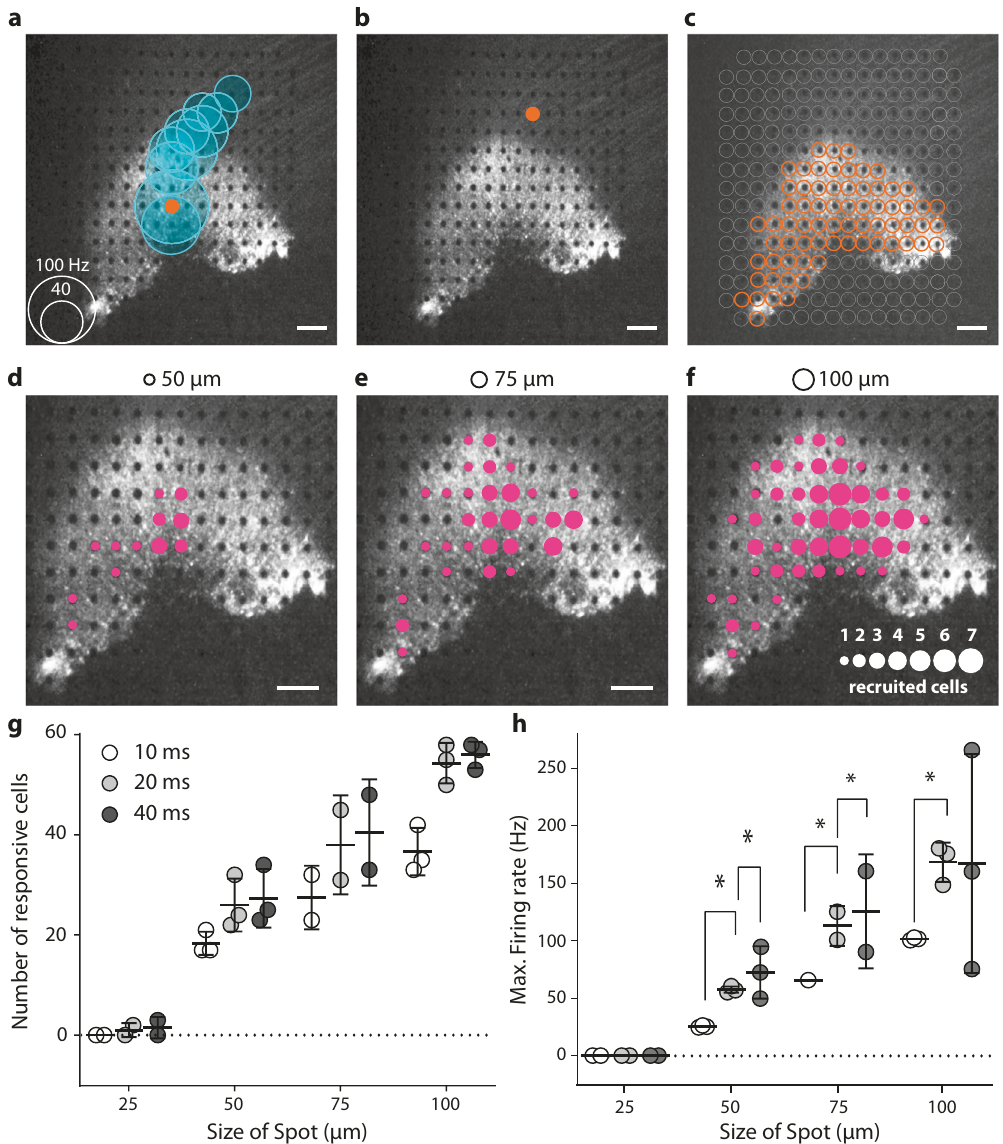
Fig. 5 Spatiotemporal resolution for discrete stimulation. a A focal light stimulation activated several different electrode channels on the transfected perifoveal area. The black and white image shows the fl uorescence present in the perifovea area, with electrodes visible as black dots The orange dot shows the site of light stimulation (with a diameter of 100 µ m and a duration of 40 ms spots. The blue circles are centered on the channels for which spikes were recorded suggesting a strong propagation activity. The size of the blue circles is proportional to the maximum spiking rate within a 100 ms window after stimulation, according to the scale in the bottom left corner. b When the light spot is directed toward another electrode at a location at which the RGC axons were stimulated, rather than the soma as in a; no response was measured (absence of blue circles). c Orange dots represented the sites at which stimulation resulted in a spiking response recorded on at least one MEA channel. These locations exactly match the pattern of intense fl uorescence in the perifoveal area. d – f Images showing the extent of responses for 20 ms presentations of spot stimuli of different sizes (displayed at the top of the images). The sizes of the magenta circles indicate the numbers of cells activated by a spot at that particular position (see the scale in the lower right part of the panel). For a – f , scale bars indicate 200 µ m. g , h Total number of recorded cells ( g ) and mean fi ring rate ( h ) over the entire electrode array is highly correlated with spot size and duration. For all stimulus durations (10 ms, 20 ms, and 40 ms), the increase in size from 25 to 50 µ m, 50 to 75 µ m, and 75 to 100 µ m led to a signi fi cant increase in the fi ring rate of the cells, not shown on the fi gure (all P < 0.005, n = 3, see “ Methods ” for details); for increases in duration for single spot size, the results of statistical analyses are displayed on the fi of the eyes treated displayed an in fl ammatory response (Supple- higher light sensitivity (Fig. 2). This greater coverage would mentary Fig. S1), with only a few cells in the vitreous and one eye enlarge the patient ’ s visual fi eld, translating to ~6° in the visual fi eld (211 µm on the primate retina per degree angle 36 ). A visual displaying vitreal haze (associated with light hemorrhaging dur- fi eld of this size may appear rather limited, but it should be borne ing the IVT procedure). Doses of 5 × 10 10 and 5 × 10 11 vg/eye induced ChR-tdT expression and strong functional responses in mind that the fovea is the center of high visual acuity. This highly ef fi ciently in NHPs. The highest dose used here (5 × 10 11 high visual acuity results from the high density of cone photo- vg/eye) appears to provide more extensive retinal coverage and receptors, and the marked predominance of midget RGCs, which